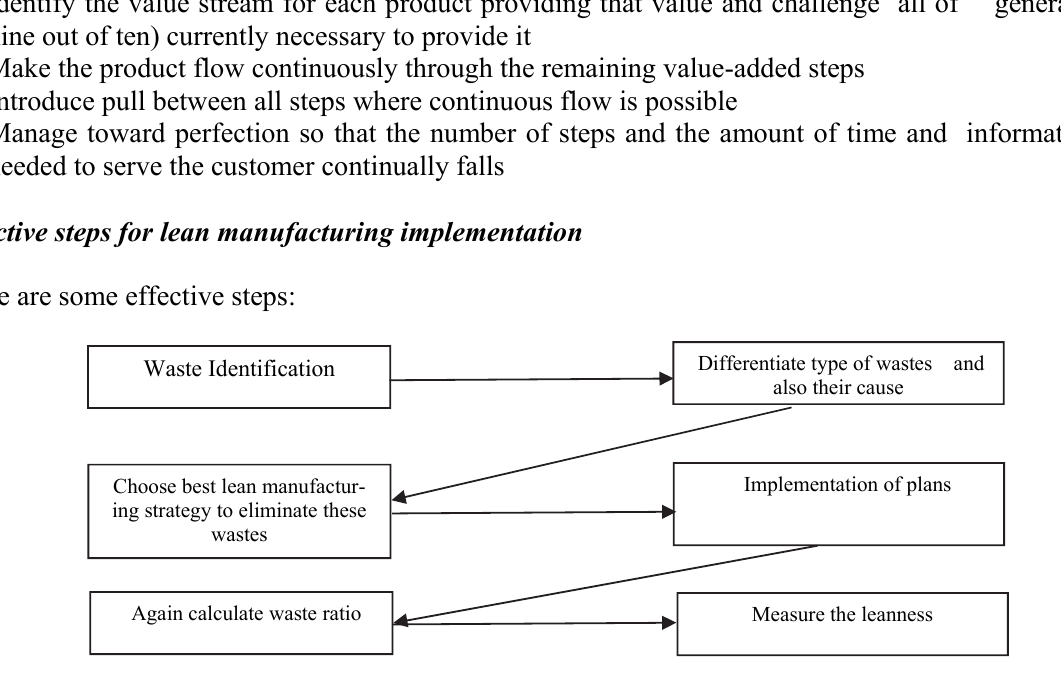
Fig. 1. Lean manufacturing